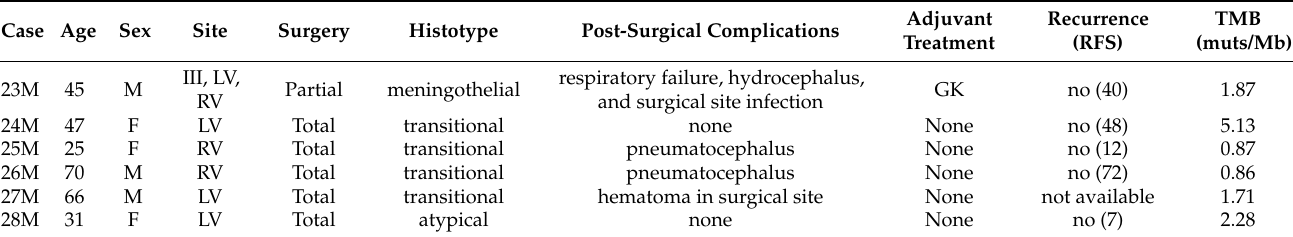
Table 1. Clinical-pathological features and TMB of six